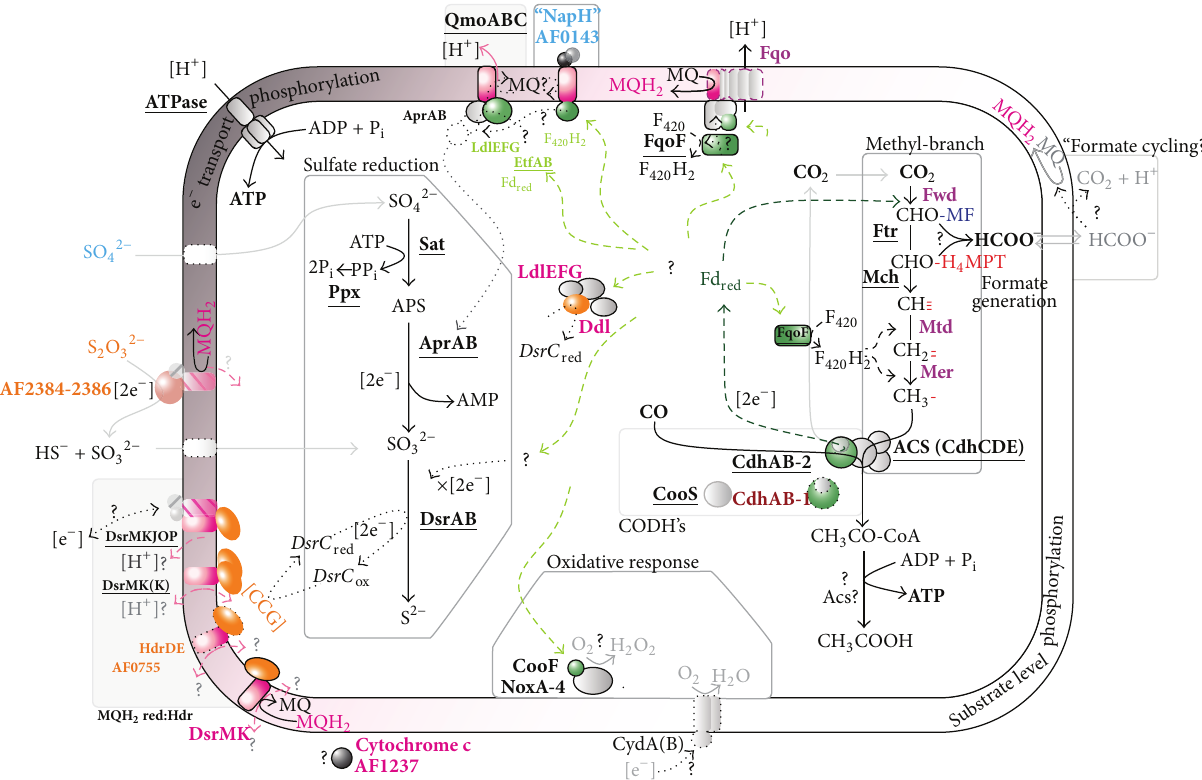
Figure 4: Presentation of putative mechanisms of energy conservation in A. fulgidus during carboxydotrophic growth. Acetate generation is probably a result of substrate level phosphorylation (right). Energy conservation is also coupled to electron transport phosphorylation (left) when electron acceptors sulfate (SO 42 − ) or thiosulfate is present (S 2 O 32 − ). Dotted lines indicate pathways of electron flow. Probable or putative paths of electron transport from Fd red to the terminal electron acceptor are shown in green or light green, respectively. Names of gene products are highlighted accordingly: in bold: expressed at or upregulated to high signal intensity ( > 3); underlined: constitutively expressed. The colors indicate the condition corresponding to upregulation (as in Figure 1(b)): blue: S-CO; orange: T-CO; magenta: Ø-CO. Downregulated genes during Ø-CO: purple (for data, see Table S2 in Supplementary Material). Cofactors of the methyl-branch: methanophenazine (MF), 5,6,7,8- tetrahydromethanopterin (H 4